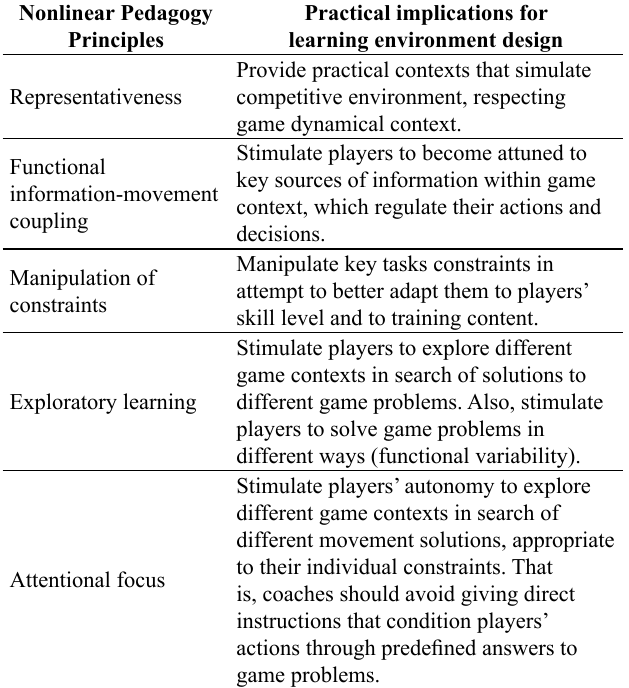
Table 1. Practical implication of Nonlinear Pedagogy principles for learning environment design 10,26